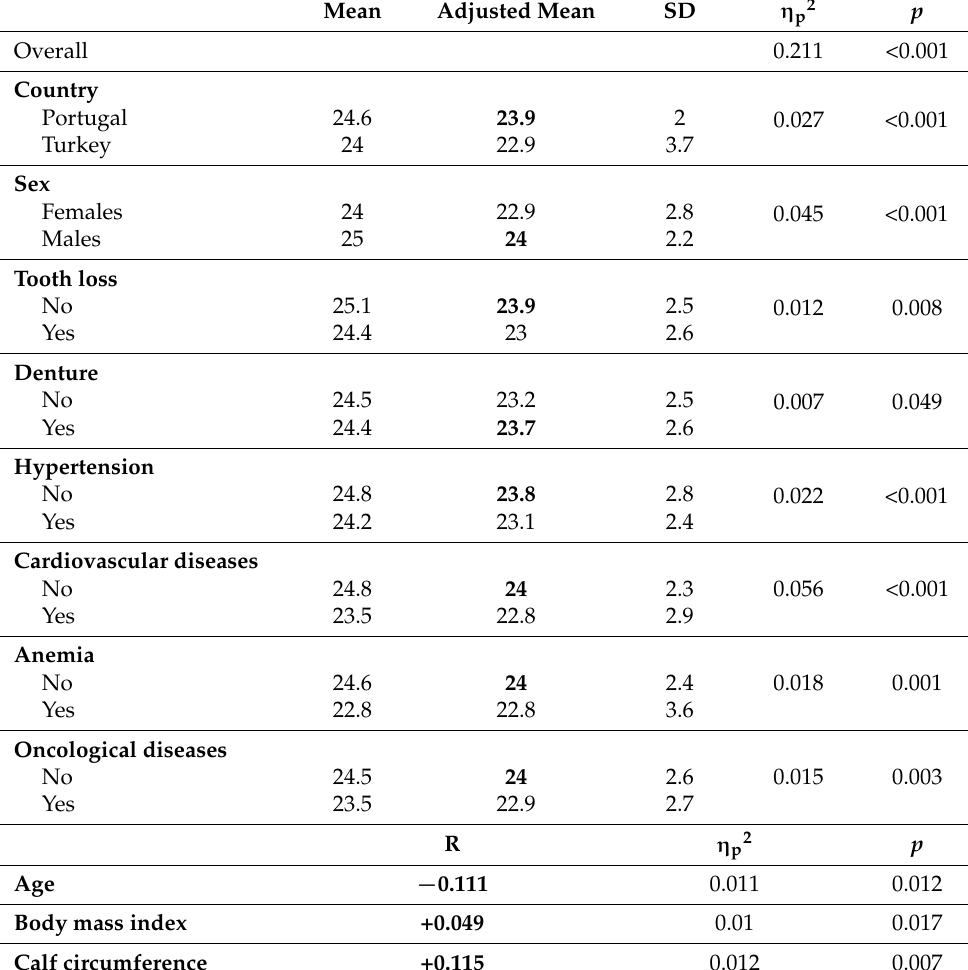
Table 4. Relationships between MNA-FF scores and sociodemographic, clinical and anthropometric variables